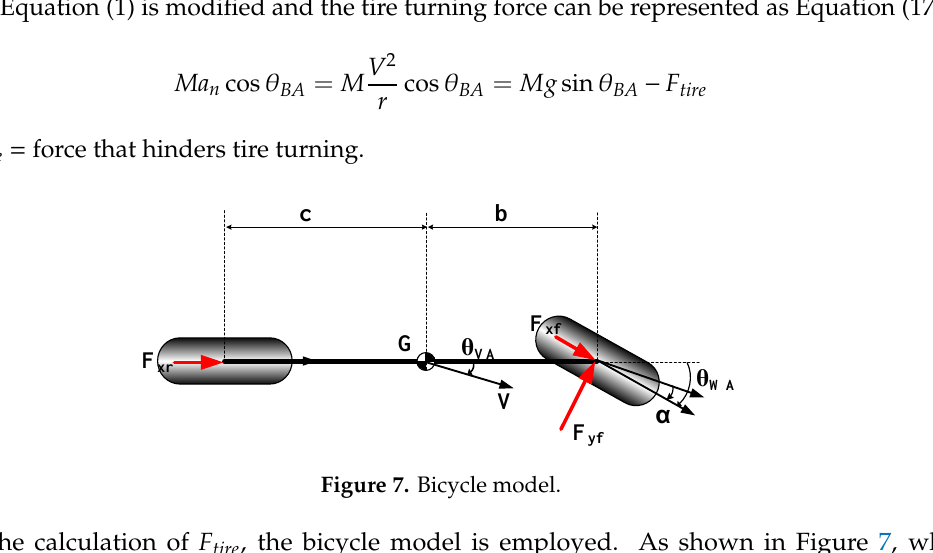
Figure 6. Steering system model.